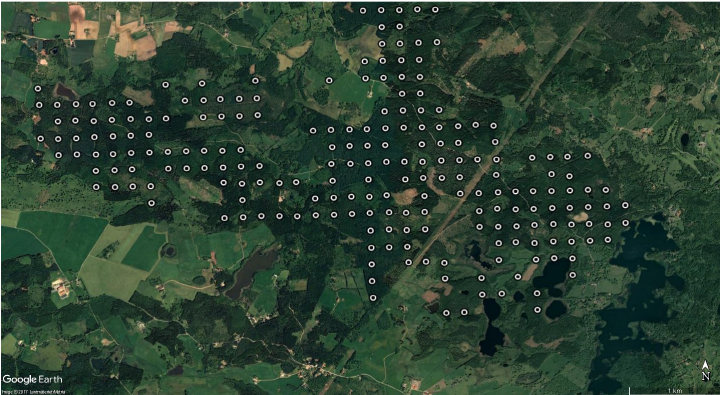
Figure 2. Location of field plots on Remningstorp area image. Google earth V 6.0. Remningstorp, Sweden. The center coordinates are 58 ◦ 30 (cid:48) N and 13 ◦ 40 (cid:48) E, and the area is 1200 ha. Eye alt 3.58